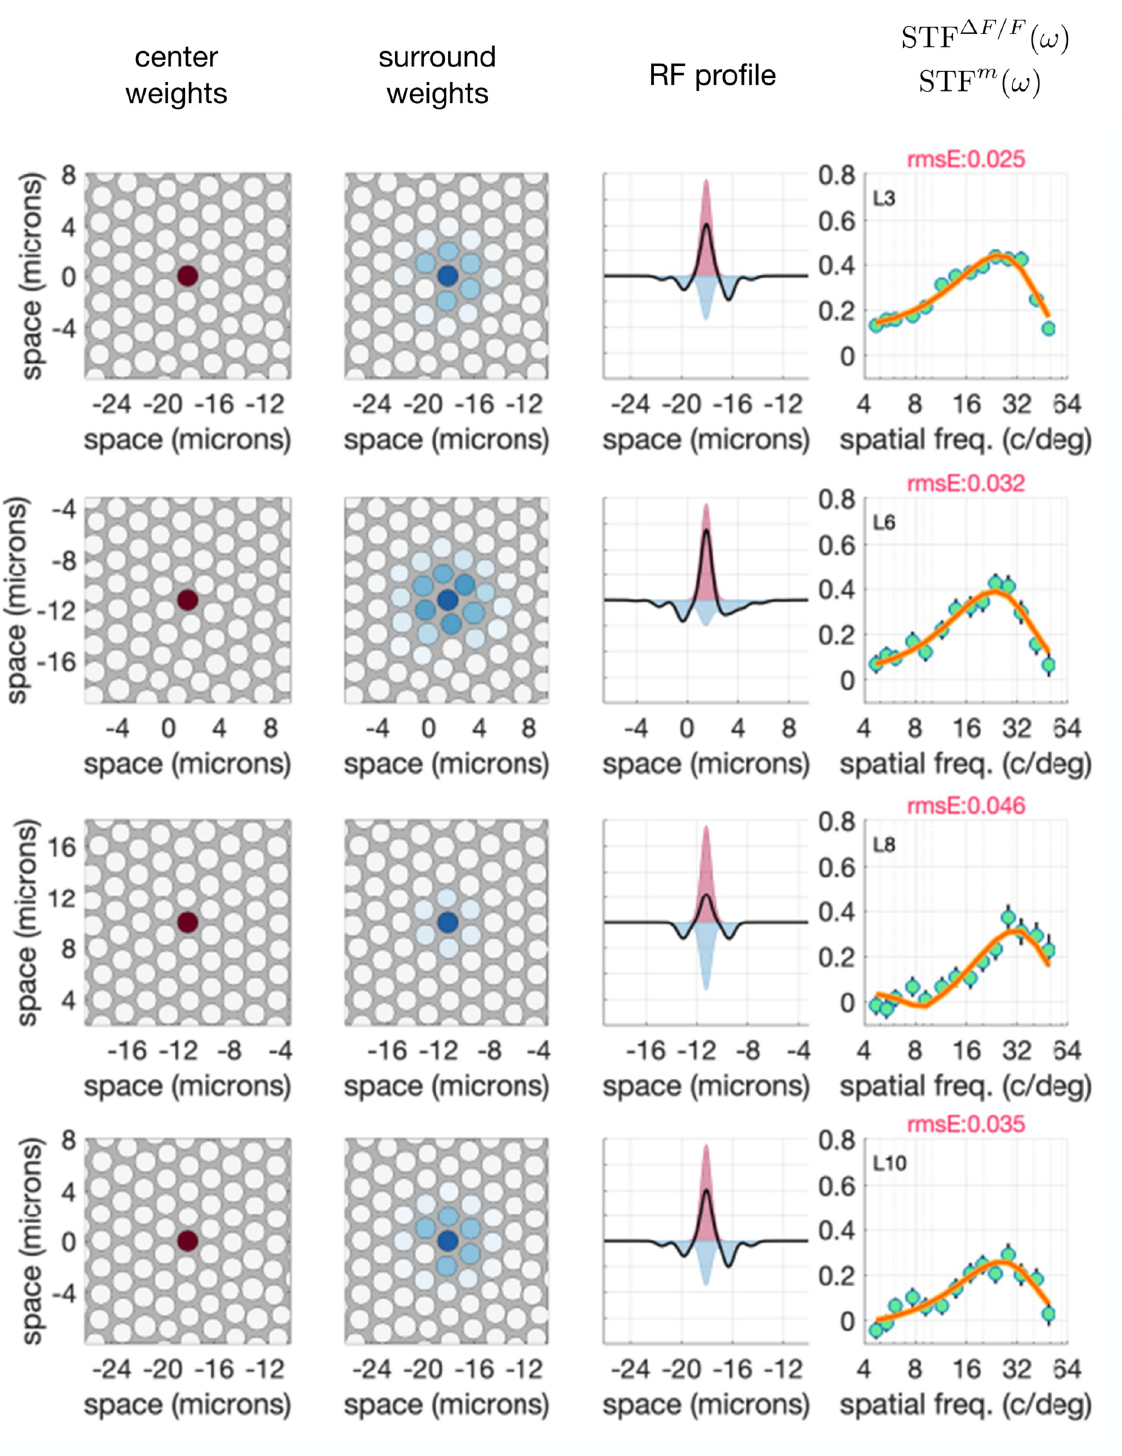
PLOS ONE | https://doi.org/10.1371/journal.pone.0278261 November29,